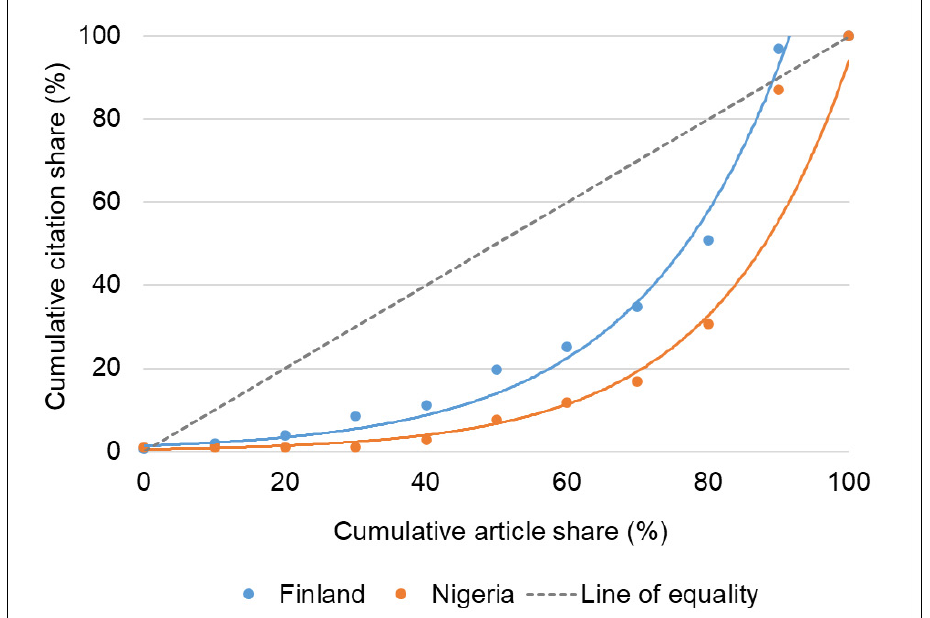
Figure 1: Lorenz curves for cumulative citation and article shares for Finland and Nigeria in